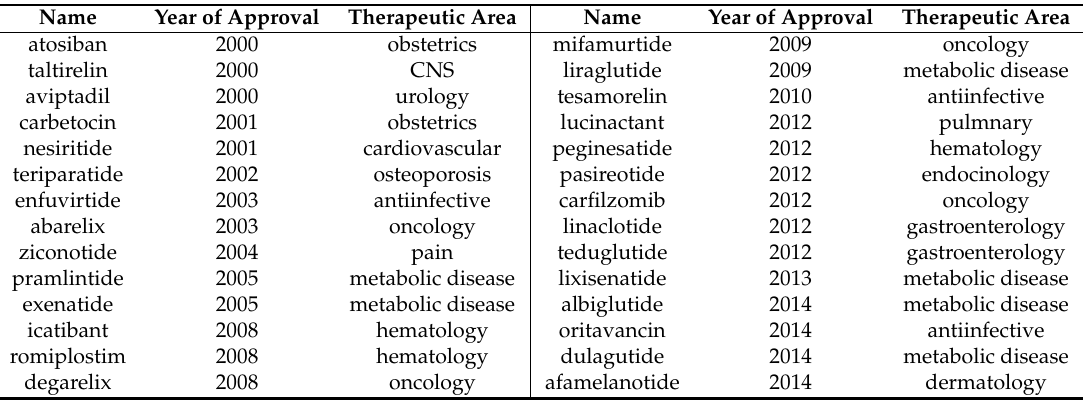
Table 1. Non-insulin peptides approved in the years 2000–2016